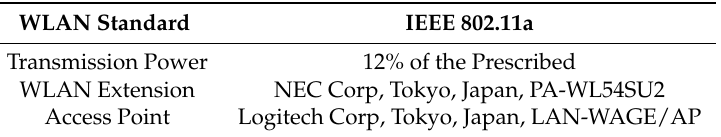
Table 1. The Specifications of the WLAN system.